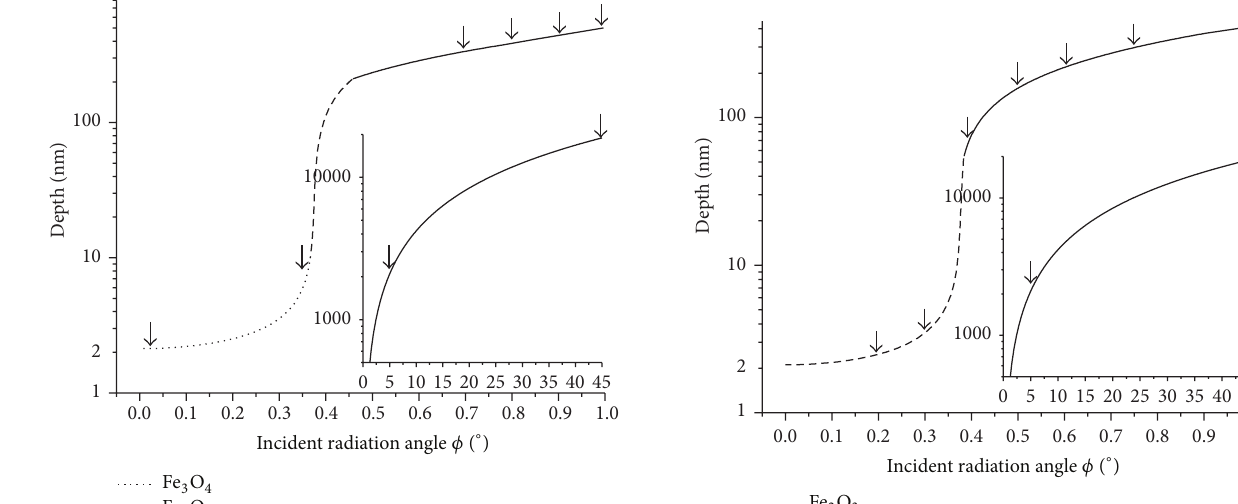
value, with this discrepancy being carried to the 𝑧 1/𝑒